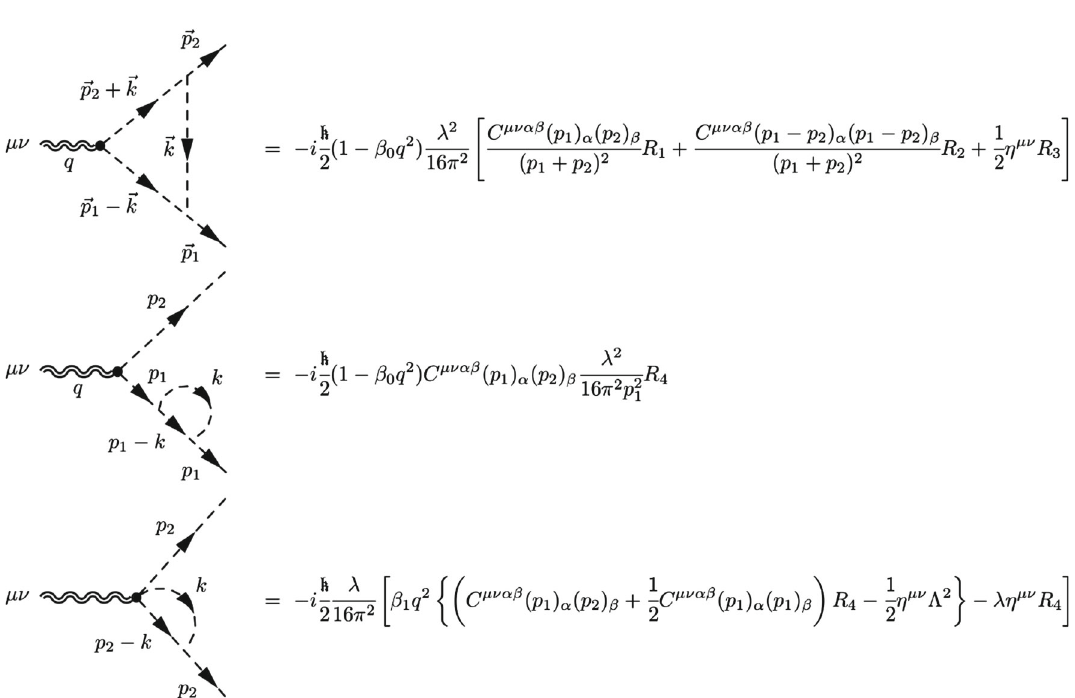
Fig. 5 Expressions for one-loop